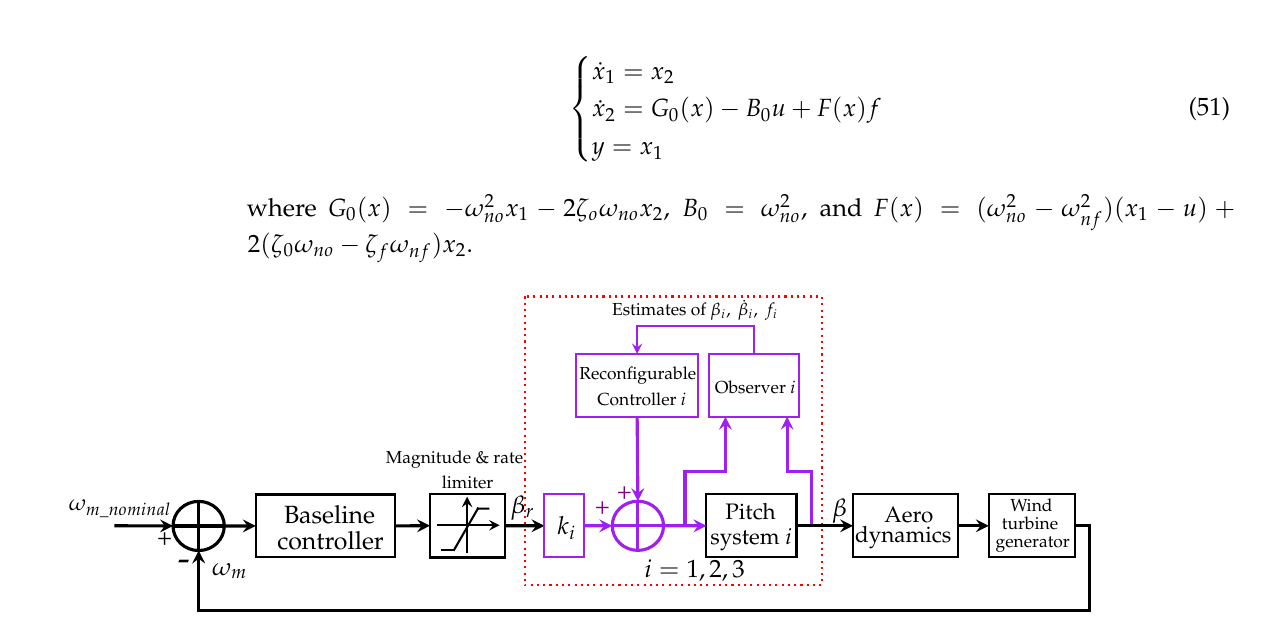
Figure 7. Schematic diagram of pitch control with